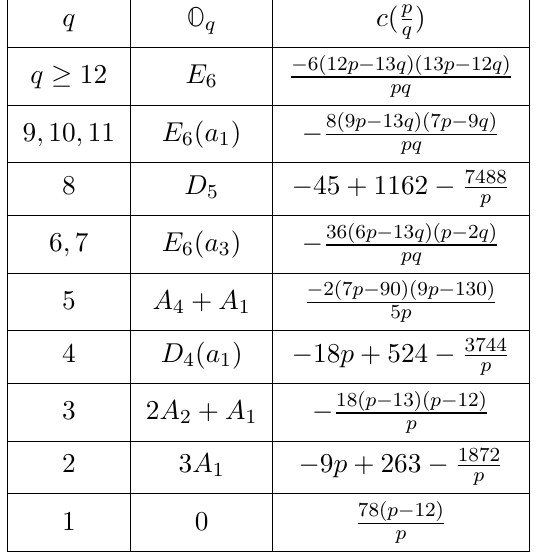
Table 8 . Orbits in E 6 Lie